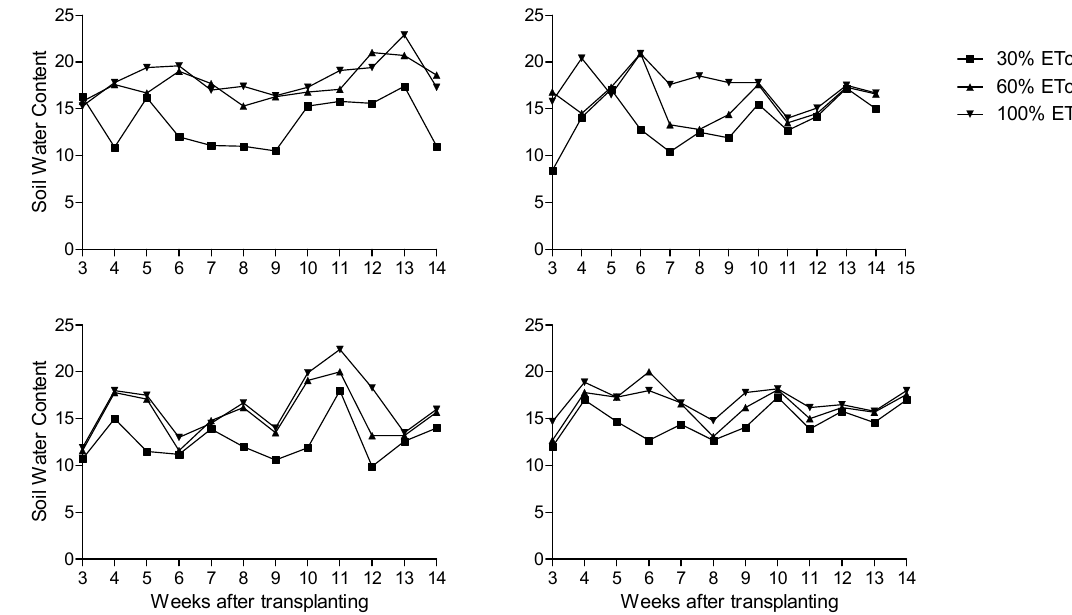
Figure 1. Volumetric soil water content observed from 3 weeks after transplanting (WAT), showing differences between the 30%, 60% and 100% ETc water regimes or cowpea, Amaranthus, Corchorus, and Swiss chard.